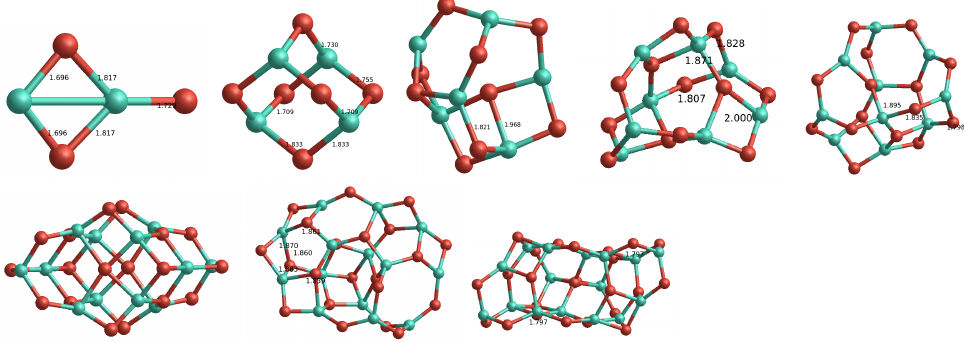
Figure 4. The adiabatically optimized structures of (Al 2 O 3 ) n+ cations. Al atoms are in green; O atoms in red; numbers correspond to bond distances in